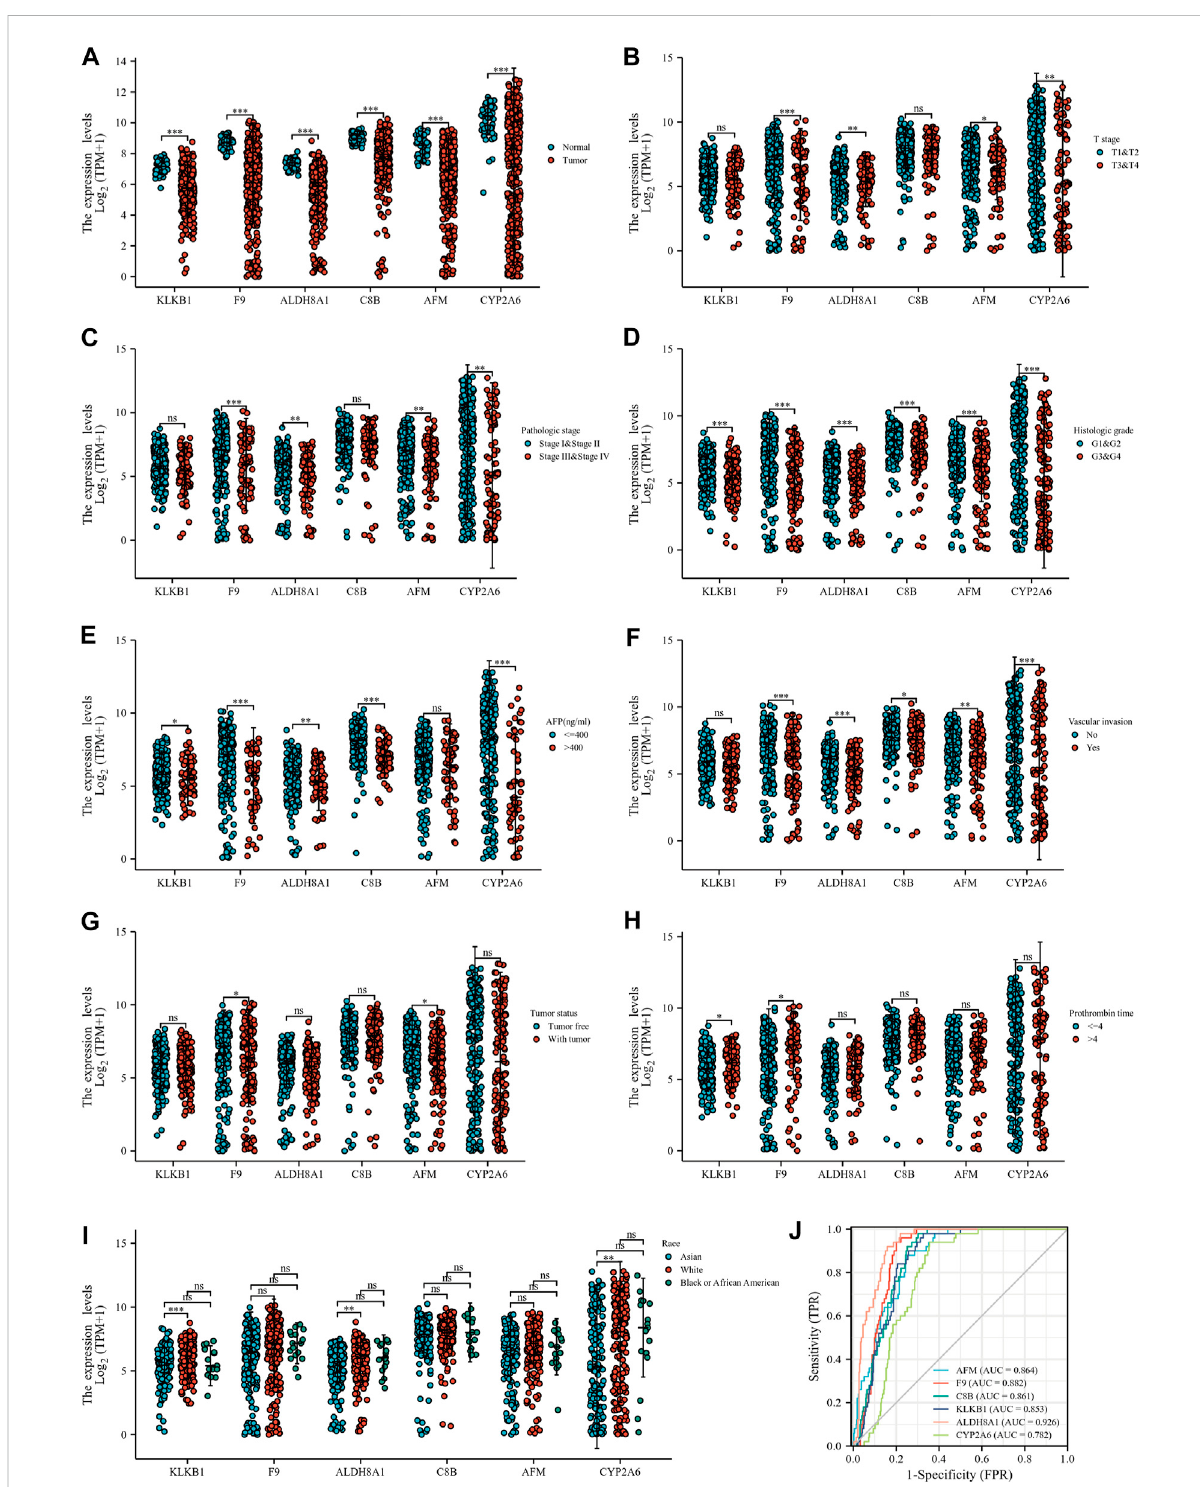
FIGURE 9 Correlation between down-regulated hub genes and clinicopathological features. (A) Down-regulated hub DEG expressions in HCC and normal tissues based on TCGA database. (B – I) Correlation between down-regulated hub genes and T stage (B) , pathologic stage (C) , histological grade (D) , AFP (E) , vascular invasion (F) , tumor status (G) , PT (H) , and race (I) . (J) ROC curve of down-regulated DEGs in the diagnosis of